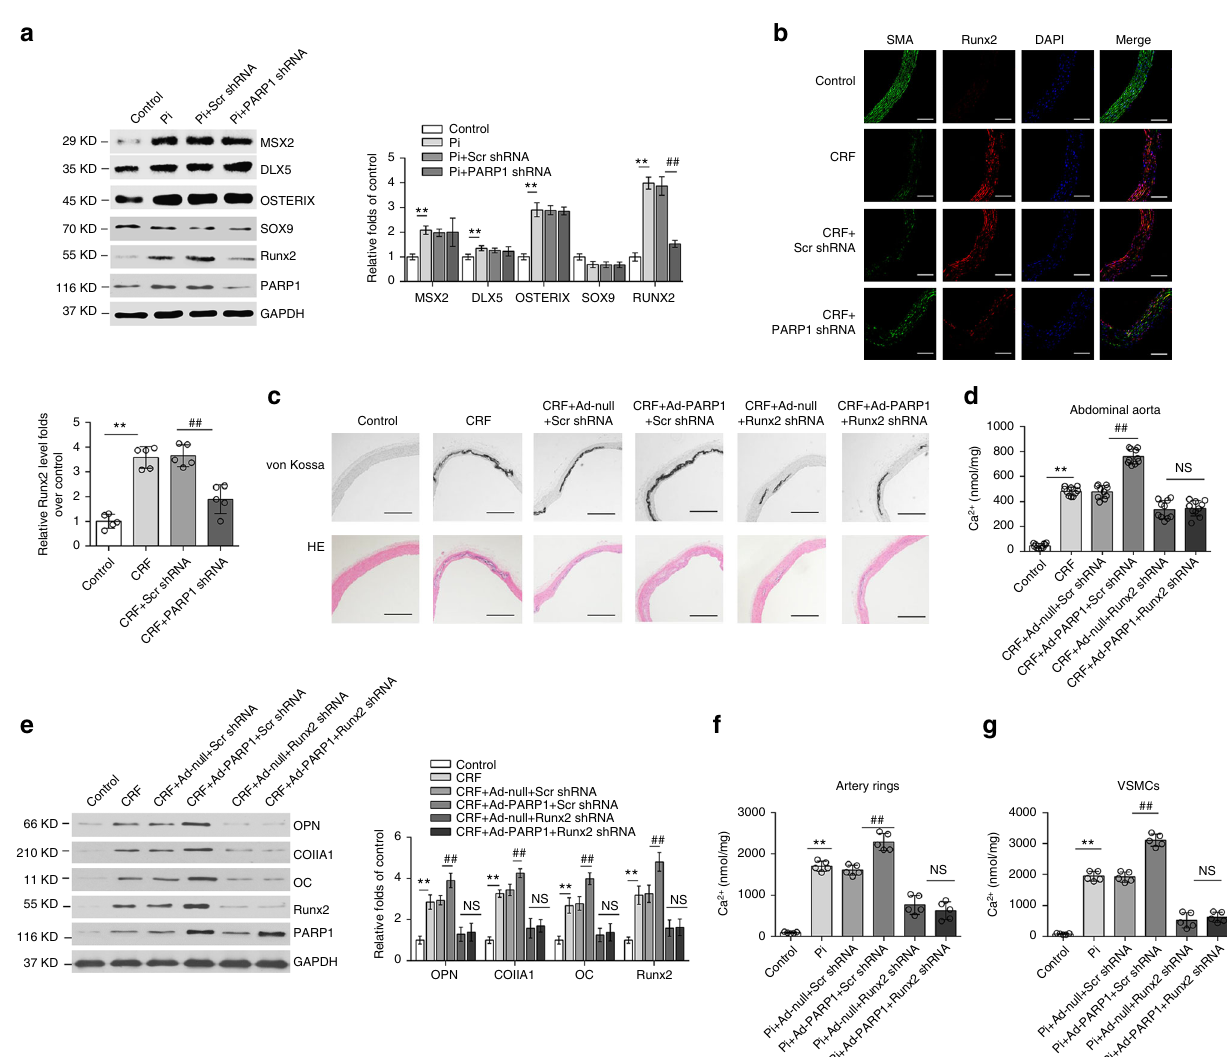
Fig. 4 Runx2 acts as a mediator of the pro-calcifying effects of PARP1. a Western blot analysis of several osteogenic factors expression in calci fi ed VSMCs transfected with Scr or PARP1 shRNA. ( n = 5 per group). b The expression levels of Runx2 and SMA in abdominal arteries of indicated groups were determined by immuno fl uorescence staining. ( n = 5 per group). Scale bar, 100 μ m. c – e Rat abdominal aortas were inoculated with Ad-Scr shRNA, or Ad- Runx2 shRNA together with Ad-Null or Ad-PARP1 at three weeks after the adenine diet. Six weeks later, arteries were isolated and the calci fi cation was analyzed by H&E, von Kossa staining ( c ) and the calcium quanti fi cation ( d ) ( n = 10 – 12 per group), and the downstream osteogenic markers (OPN, ColIA1, OC, and Runx2) were analyzed by western blot ( e ). ( n = 5 per group). Scale bar, 100 μ m. f , g The aortic rings ( f ) or rVSMCs ( g ) were pre-infected with Ad- Scr shRNA, or Ad-Runx2 shRNA together with Ad-Null or Ad-PARP1, and exposed to the osteogenic medium for 14 days. The calci fi cation was determined by the calcium assay respectively. ( n = 5 for each group). Statistical signi fi cance was assessed using one-way ANOVA for multiple comparison and is presented as follows: NS: no signi fi cance, ** P < 0.01 and ## P < 0.01. All values are means ± S.D. Source data are provided as a Source Data fi